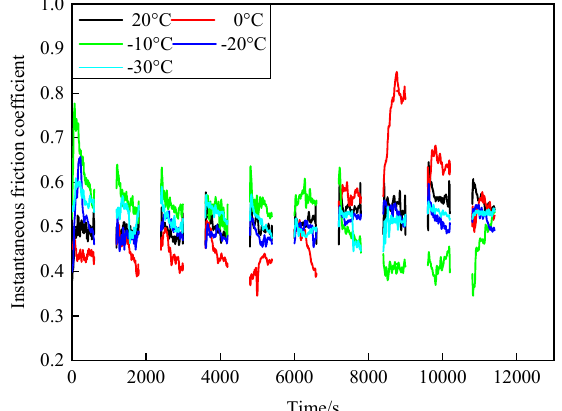
Figure 4. Instantaneous friction coefficient curve.